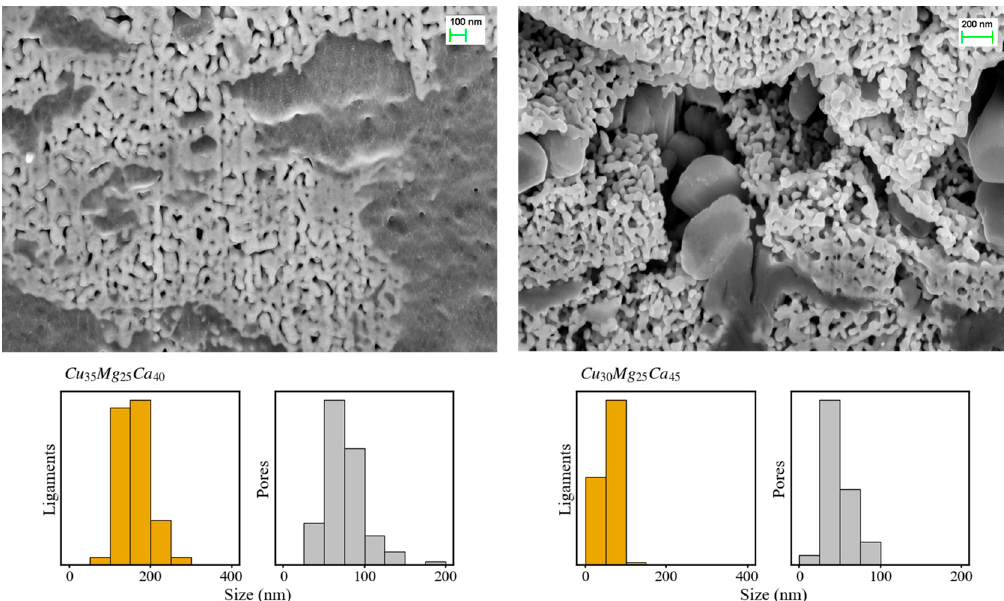
Figure 8. Images of the nanoporous copper structure formed near the surface of Cu35 ( left ) and Cu30 ( right ) samples. The corresponding size distributions of ligaments (orange) and ligaments (grey) are shown below.